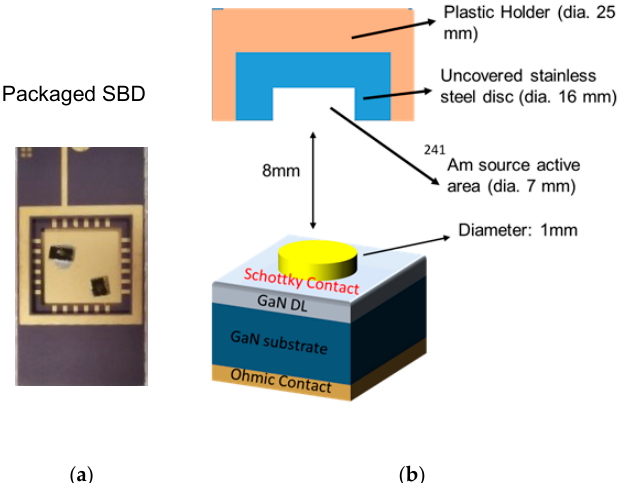
Figure 16. ( a ) Packaged Device and ( b ) Schematic drawing of Source-Detector measurement setup (not to scale).